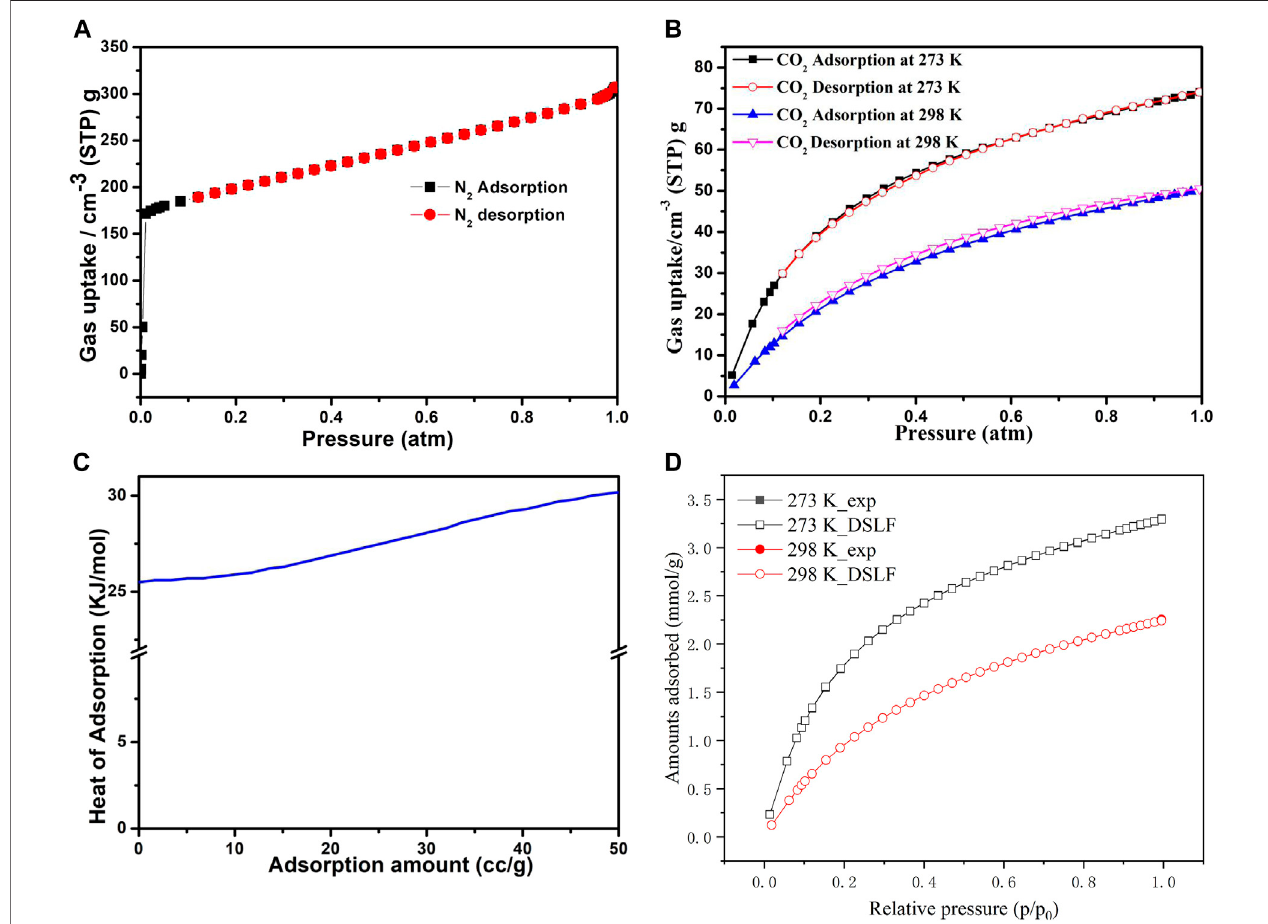
FIGURE 4 | (A) N 2 adsorption isotherms of 1a at 77 K; (B) CO 2 adsorption isotherms of 1a at 273 K, 298 K; (C) Heat of CO 2 adsorption as a function of uptake amount; (D) The DSLF model for CO 2 adsorption isotherms.